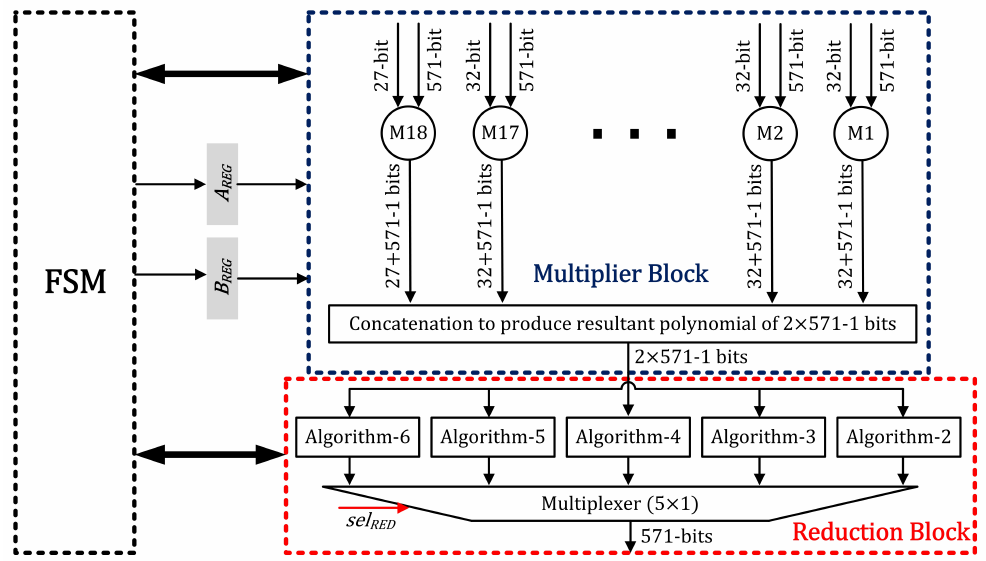
Figure 7. Block diagram of our proposed scalable multiplier architecture for NIST-recommended binary fields. Our scalable multiplier design incorporates the least-significant digit-parallel multiplication